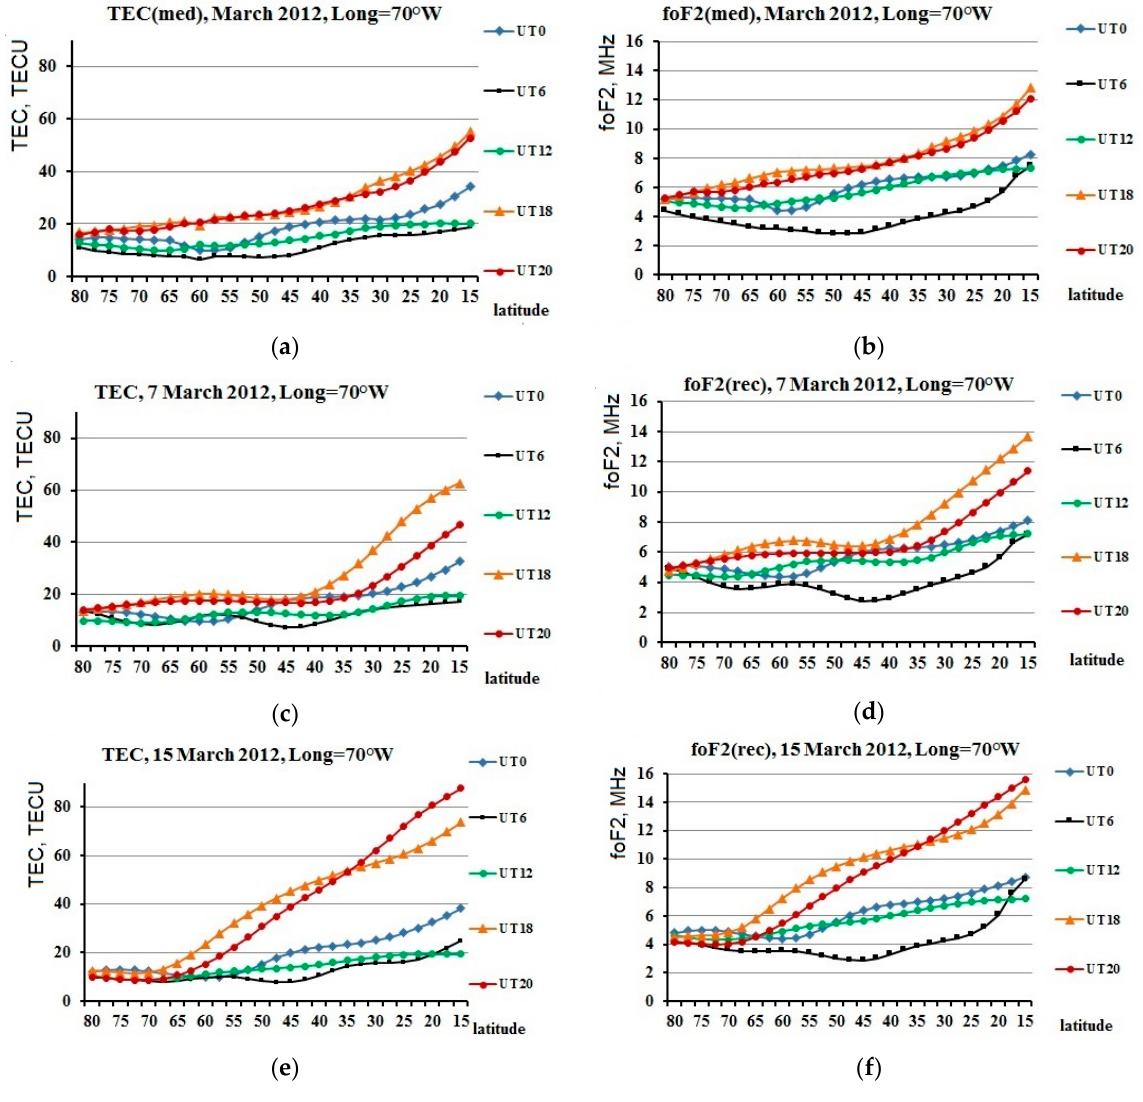
Figure 4. Total Electron Content (TEC) (left panels) and reconstructed foF2 (right panels) variations along the meridian of 70° W: ( a , b ) monthly median values; ( c , d ) during MP and RP on 7 March; ( e , f ) before and during MP on 15 March.